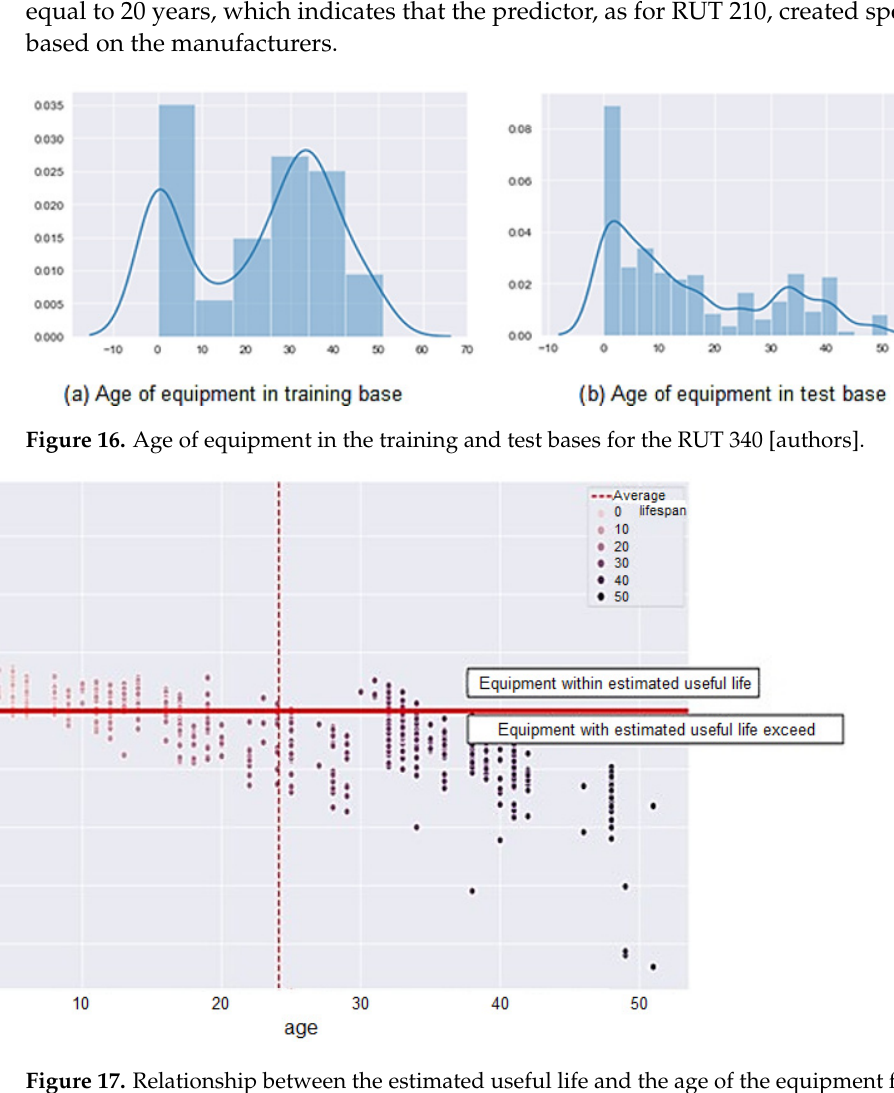
Figure 15. Relationship between the estimated useful life and the age of the equipment for RUT 210 [authors].